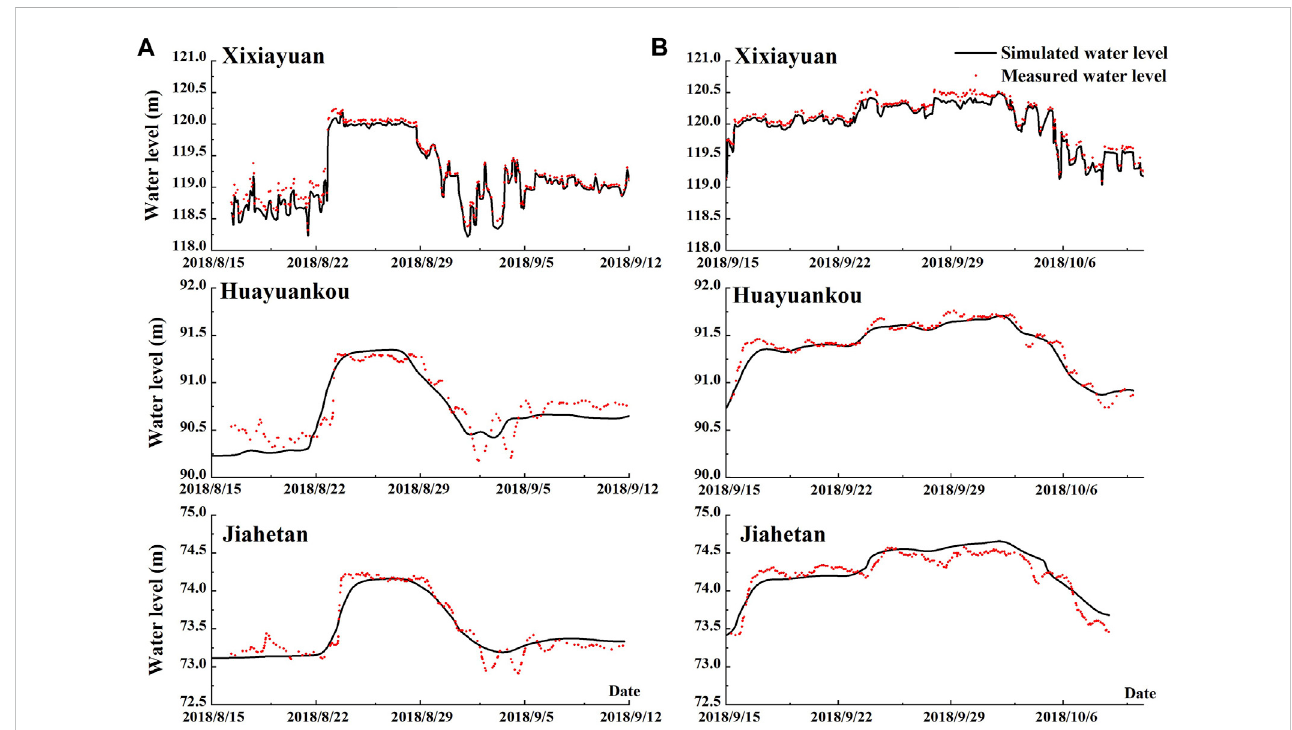
FIGURE 4 Calibrationandveri fi cationresultsofthemeasuredandsimulatedwaterlevelsofthethreehydrologicalstations(Xixiayuan,Huayuankou,andJiahetan)in the study area during 2018.8.16 – 2018.9.11 and 2018.9.15 – 2018.10.10 periods. (A) Water-level calibration results; (B) water-level veri fi cation results.